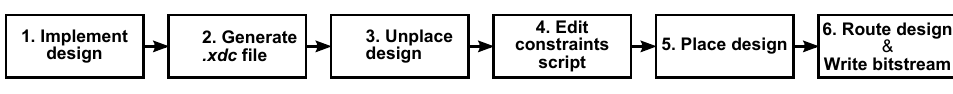
Figure 6. Flow chart of the Location Constraints Flow